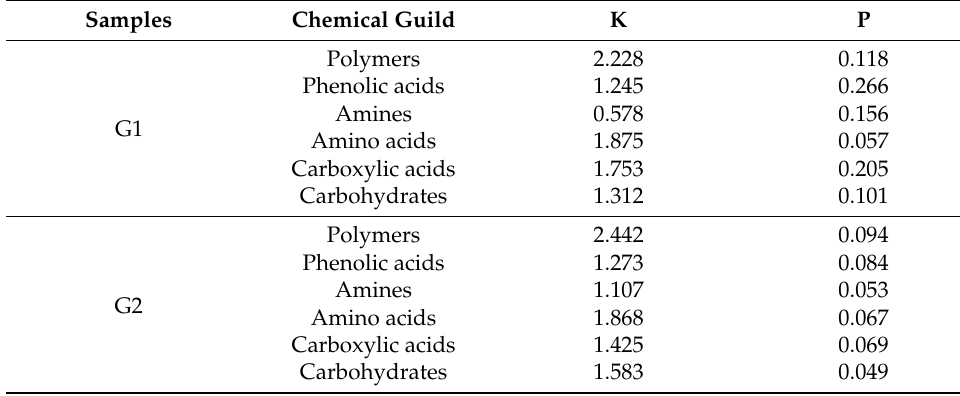
Table 3. The K and P of six types of carbon sources in four working